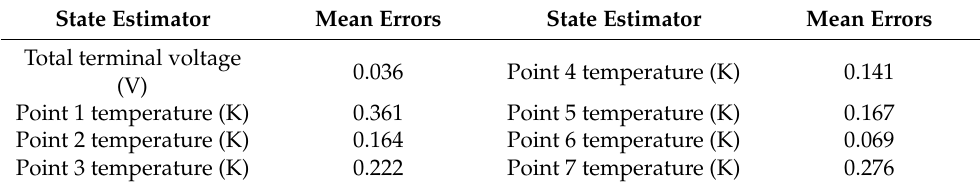
Table 5. Mean absolute errors of temperature.